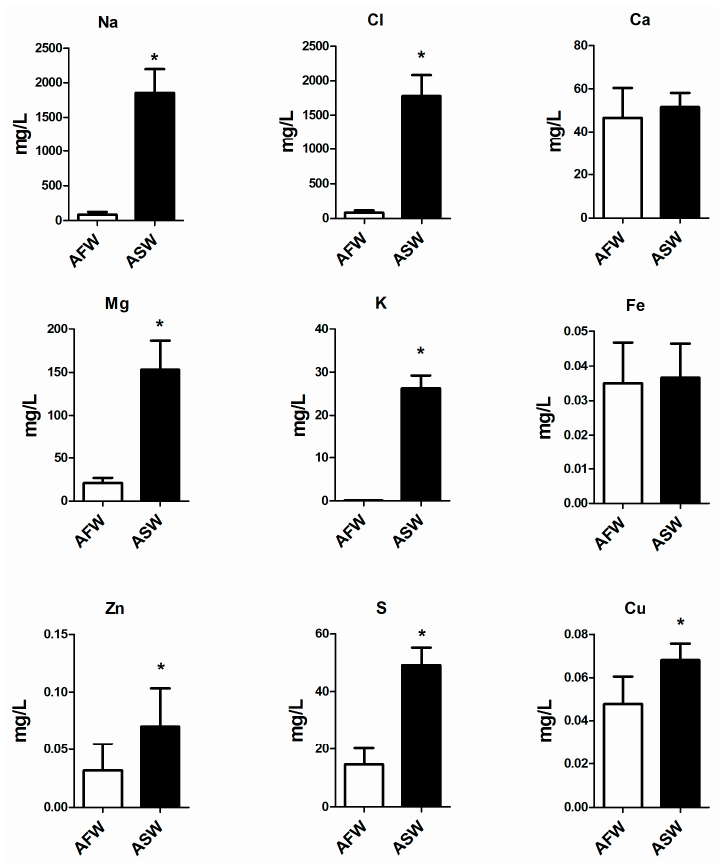
Figure 2. Concentration of Na, Cl, Ca, Mg, K, Fe, Zn, S, Cu in AFW and ASW groups, measured at the end of the trial. Statistical significance is labelled with asterisks ( p < 0.05), bars indicate SD.